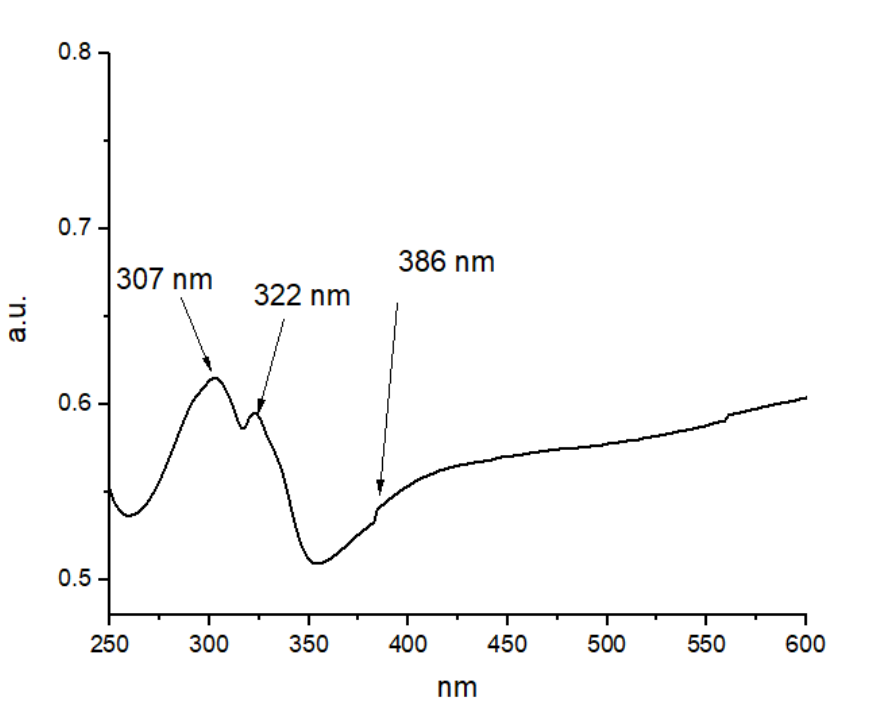
Figure 1. Absorption spectrum of the AgNPs.